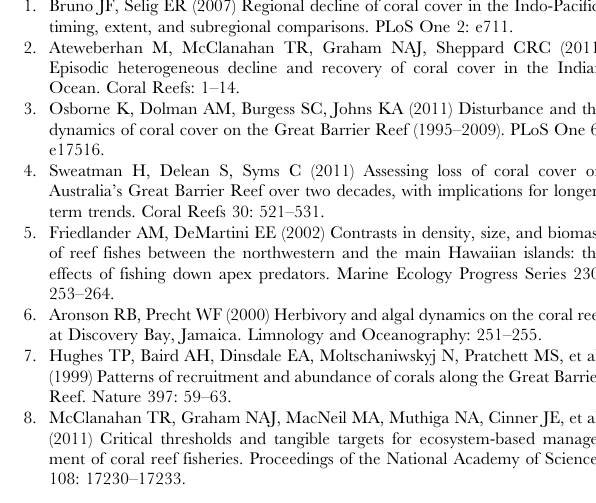
Figure S1 Correlograms of time-series coral cover data for Ningaloo Reef: A) before inclusion of correlation structure in mixed-effects model, and B) after inclusion of correlation structure. Table S1 List of documents and sources where data were derived for meta-analysis. Note: Analysis of photo and video transects were done in the lab, as opposed to visual assessments, quadrats and in-situ point or line intercept methods, which were done in the field at the time of sampling. Table S2 Results of linear regression to assess rela- tionship between latitude and coral cover by dominant families of corals off the Western Australian coast. Table S3 Results of linear regression to assess rela- tionship between coral cover of dominant families through time at each sub-region of Ningaloo Reef. Table S4 Checklist of items done during the meta- analysis